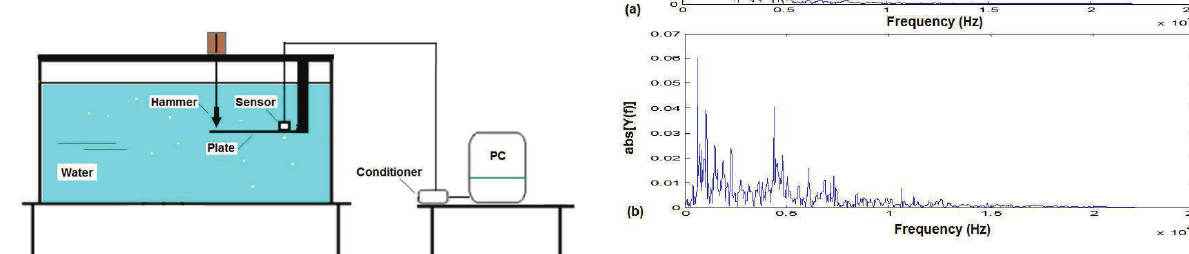
Figure 3. FFT of free-decay responses of dry plate (a) and wet plate (b).